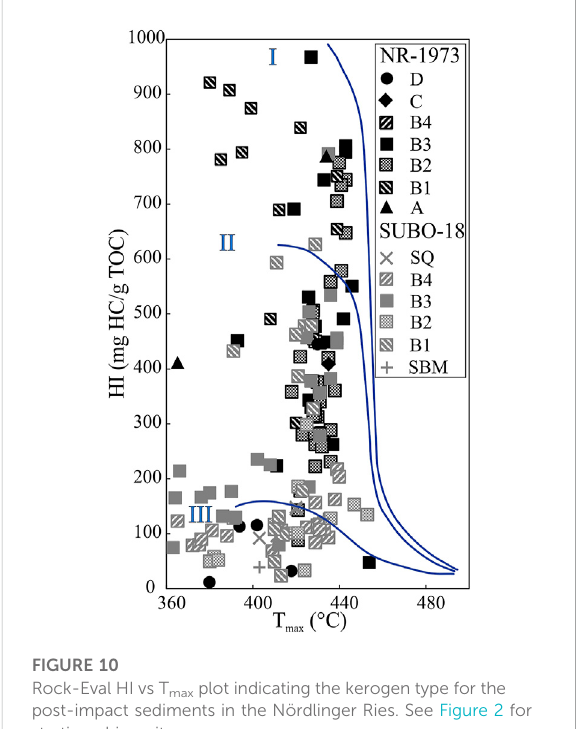
FIGURE 10 Rock-Eval HI vs T max plot indicating the kerogen type for the post-impact sediments in the Nördlinger Ries. See Figure 2 for stratigraphic